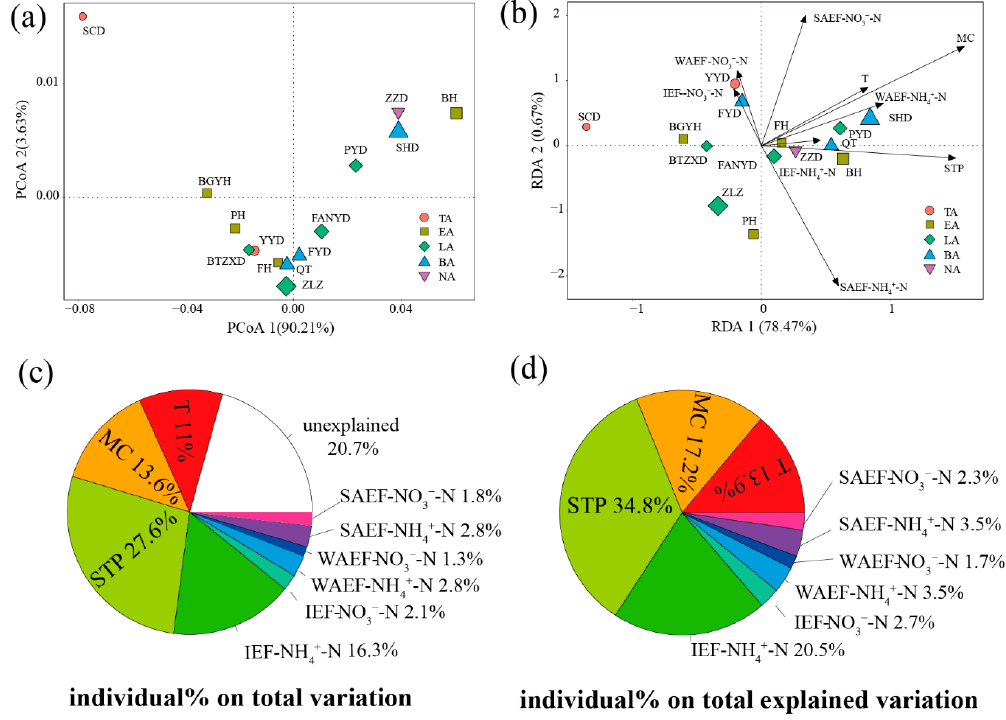
Figure 3. PCoA, RDA, and HP of aerobic denitrifying microbial community α -diversity in Baiyangdian Lake. ( a ), PCoA of aerobic denitrifying microbial community α -diversity; ( b ), RDA of aerobic denitrifying microbial community α -diversity; ( c )( d ), HP of aerobic denitrifying microbial community α -diversity.